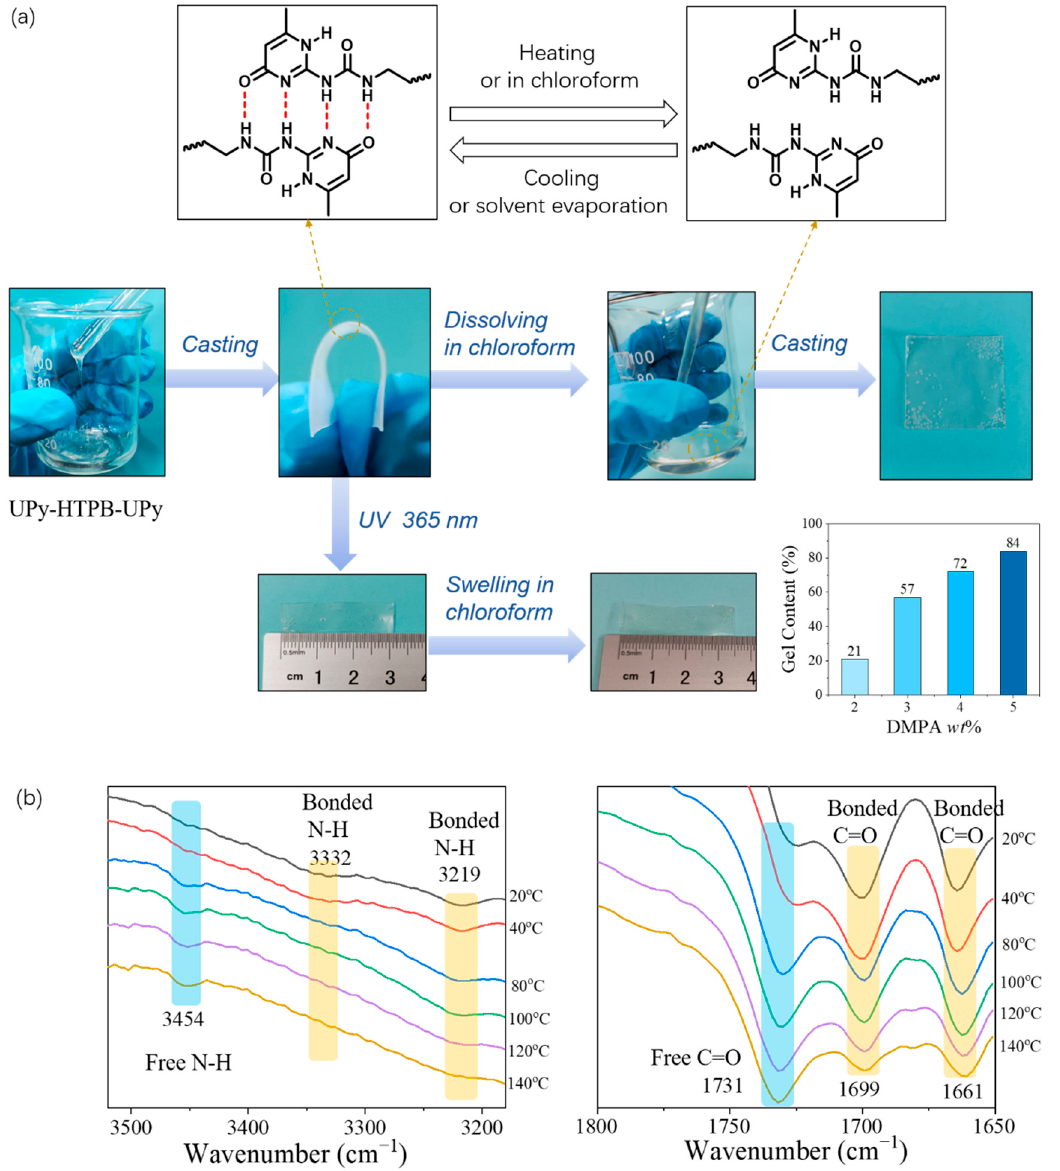
Figure 2. Quadrupolar hydrogen bonding between UPy unites: ( a ) formation and breakdown of hydrogen bond; recasting via hydrogen-bonding interaction, swelling after UV cross-linking and DMPA wt% dependent gel content (%); and ( b ) temperature-dependent (upon heating) FTIR spectra of UPy-HTPB-UPy at N–H and C=O